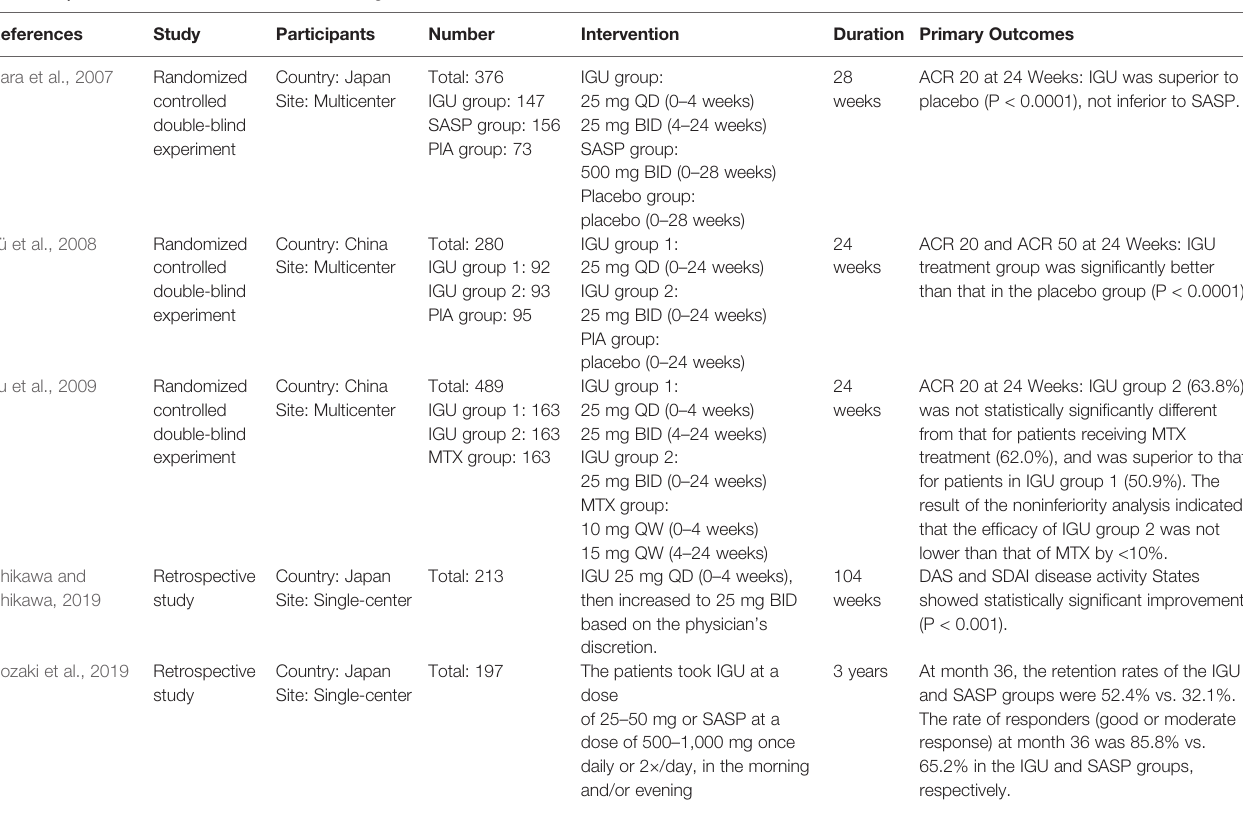
TABLE 1 | Characteristics of the clinical trials with iguratimod for